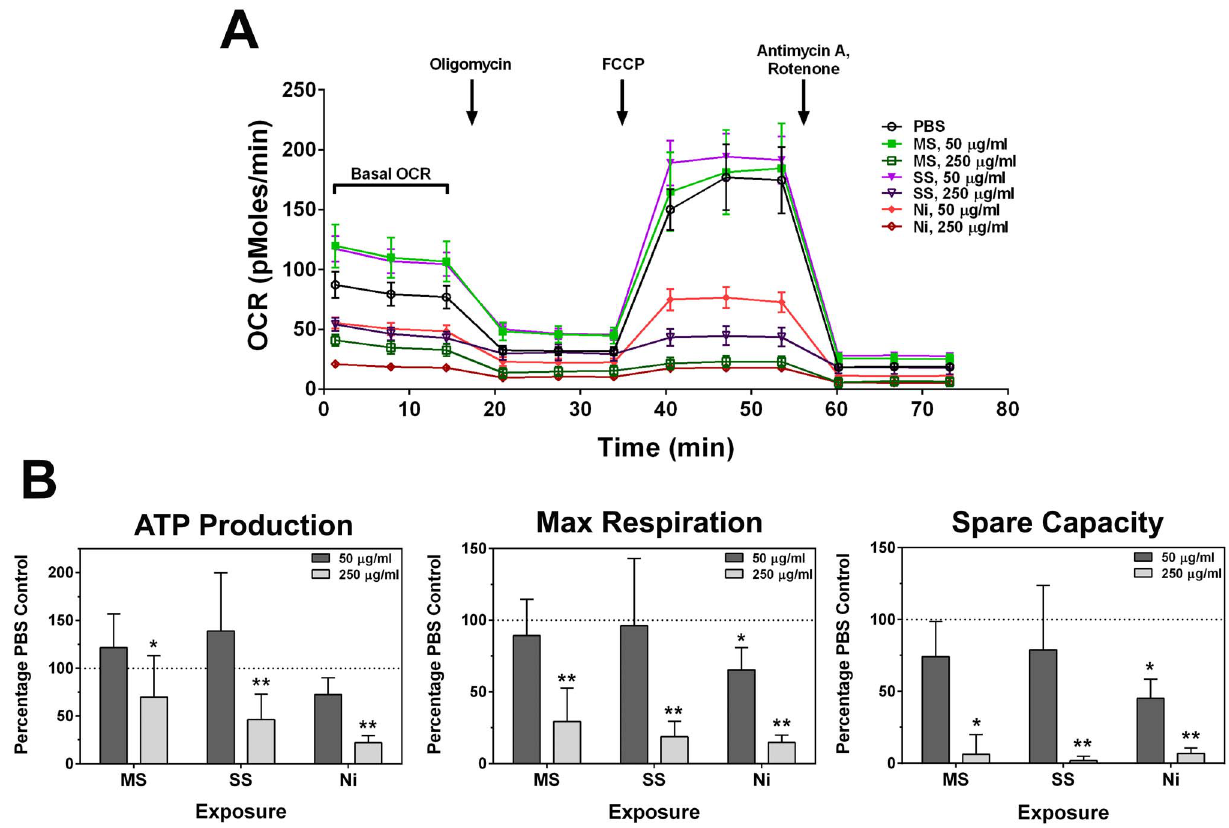
Figure 3. Mitochondrial dysfunction following incubations with welding fumes. RAW 264.7 cells were treated with suspensions of welding fumes. Following 24 h exposures at 37 u C, media were removed and wells were washed 3 times with unbuffered XF media, and the plate was run using the mitochondrial stress test kit (Seahorse Biosciences) to determine the oxygen consumption rate (OCR) at certain time points. A. Representative mean OCR traces at baseline and following injections of reagents. B. ATP production, maximum respiration, and spare capacity were calculated from the mean OCRs from 5 independent experiments. Error bars represent the mean 6 SD (n=5). *, p , 0.05 and **, p , 0.0001 compared to PBS control.